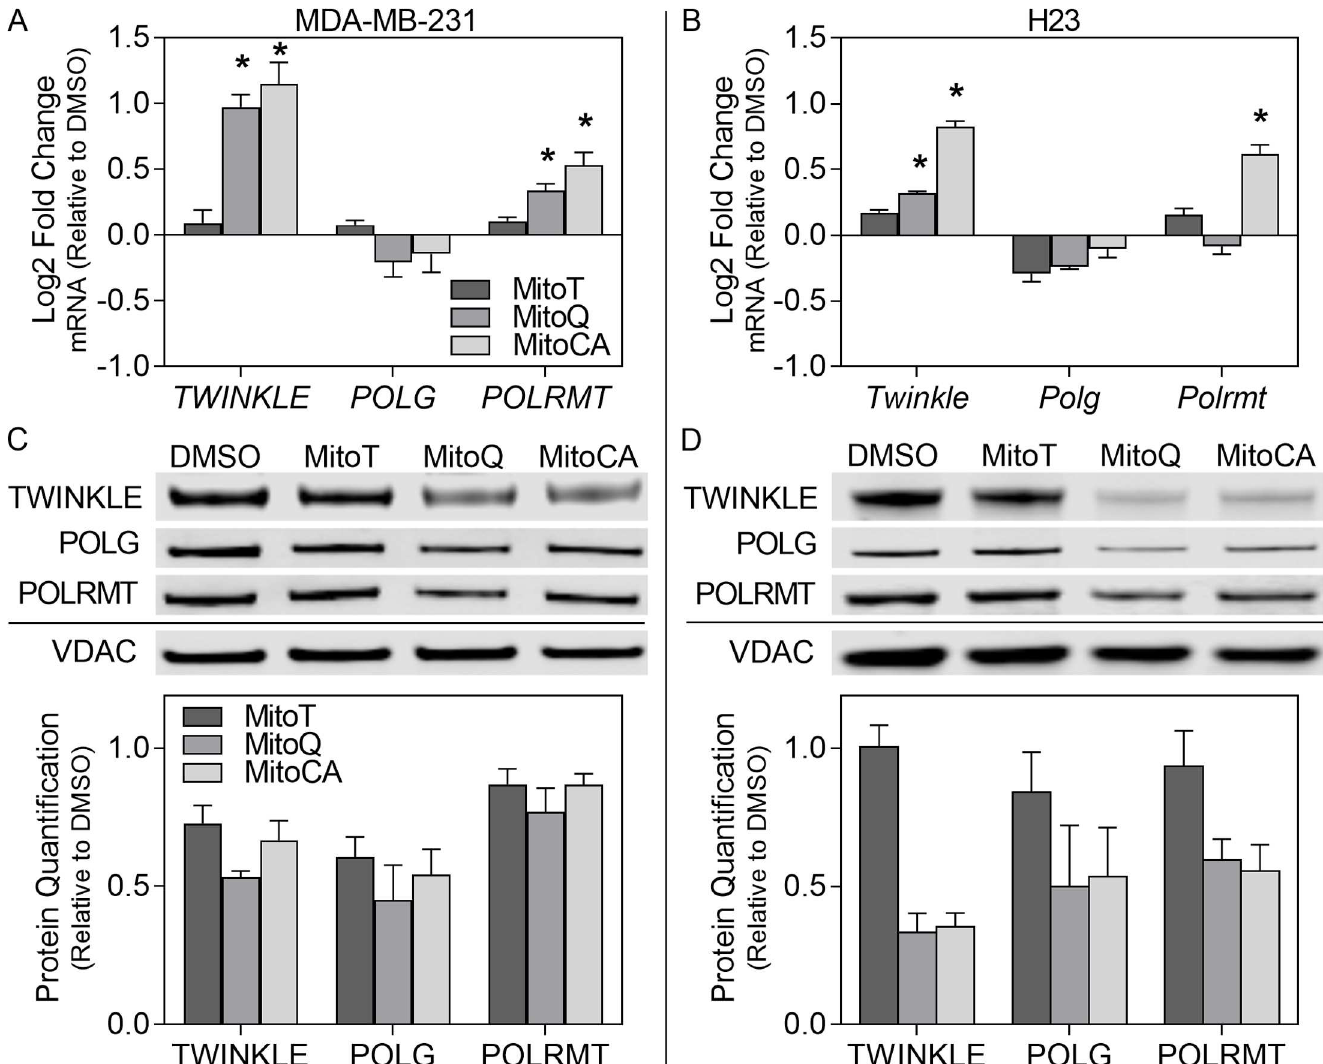
Fig 4. Mitochondrial replication machinery. Gene expression(A,C) and protein levels (B,D) for TWINKLE, POLG and POLRMT in MDA-MB-231 (A,C) and H23 (B,D) cell lines determinedby qPCR and immunoblotting. Cells were exposedto DMSO (0.02%), MitoT (dark gray bars), MitoQ (gray bars), and MitoCA (light gray bars) at 2 μ M for 24 hours. In A-B, bars represent the averagelog2 fold change normalized to GAPDH and the DMSO control. Statistical significanceis expressedas asterisks at p < 0.05relative to the DMSO control. In C-D, bars denote the mean densitometry (+/-1 SEM) of immunoblots of mitochondrial fractions normalized to VDAC and the corresponding DMSO treatment. For each assay, two independentexperiments were performed (n = 3).